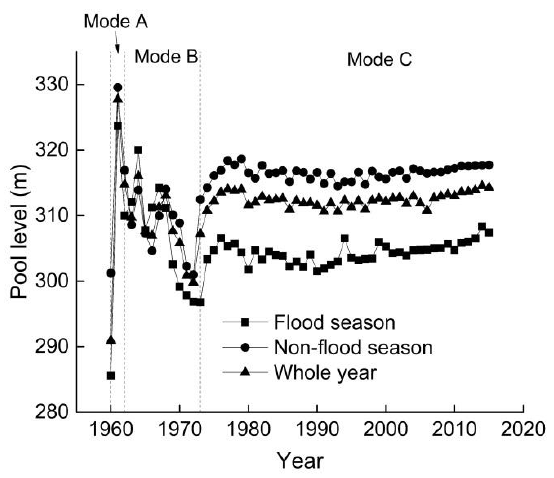
Figure 2. Pool level (water level in reservoir) of the Sanmenxia Dam from 1960 to 2015.